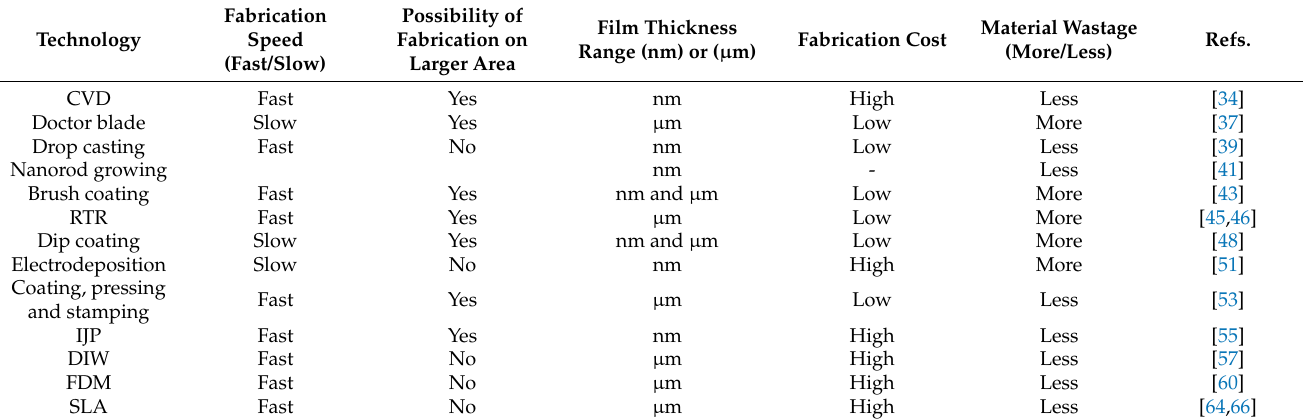
Table 3. Comparison of electrode fabrication techniques used in Li ion energy